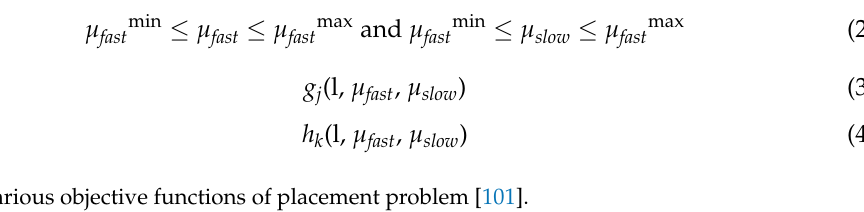
Table 2. Various objective functions of placement problem [101].